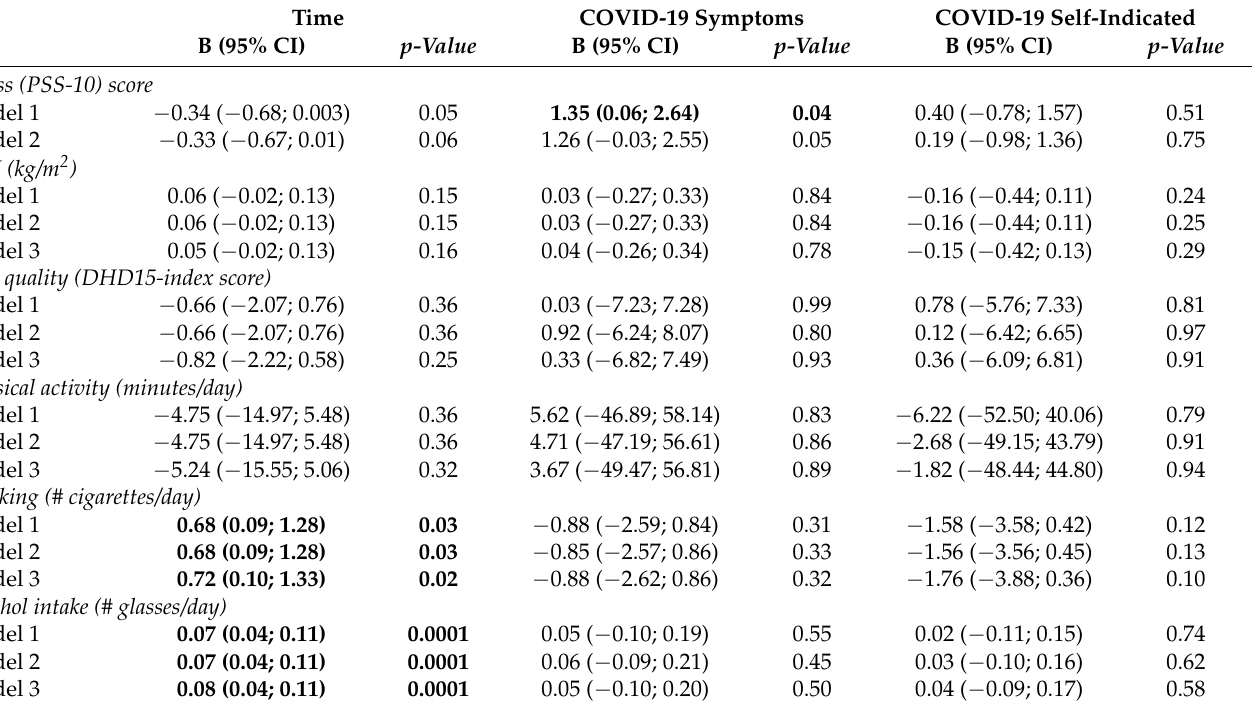
Table 4. Regression coefficients (unstandardized betas with 95% confidence intervals) of time effects and associations between presence of COVID-19-related symptoms or self-indicated COVID-19, and perceived stress, BMI, diet quality, physical activity, smoking and alcohol intake during the COVID-19 epidemic 1 .